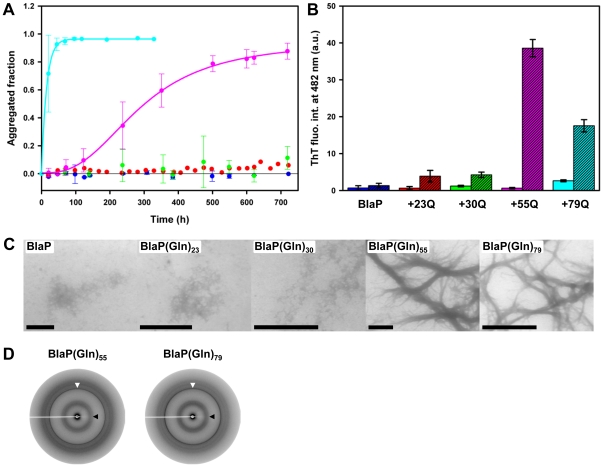
Only BlaP(Gln)55 and BlaP(Gln)79 form amyloid-like fibrils when incubated in the presence of 1.85 M urea.(A) Aggregation kinetics of 110 µM BlaP (blue), BlaP(Gln)23 (red), BlaP(Gln)30 (green), BlaP(Gln)55 (pink) and BlaP(Gln)79 (cyan) at 25°C in the presence of 1.85 M urea in PBS, pH 7.5, followed by measuring the concentration of protein remaining soluble. Time-points shown with an error bar are the average of three independent time-courses for BlaP(Gln)30, BlaP(Gln)55 and BlaP(Gln)79 and two independent time-courses for BlaP. Error bars show the standard deviations. Only one time-course was carried out with BlaP(Gln)23. (B) ThT fluorescence intensities at 482 nm in the presence of BlaP and chimeras samples at T0 (solid bars) and Tf (dashed bars). T0 and Tf correspond to the initial and final points of one time-course for each protein. Data are the average of three measurements and error bars represent the standard deviations. a.u., arbitrary units. (C) TEM images of the protein samples at Tf. The scale bar is 1 µm. (D) X-ray fibre diffraction patterns from BlaP(Gln)55 and BlaP(Gln)79 fibrils. White and black arrows indicate meridional and equatorial reflections at 4.7 Å and ca. 9.5 Å, respectively.